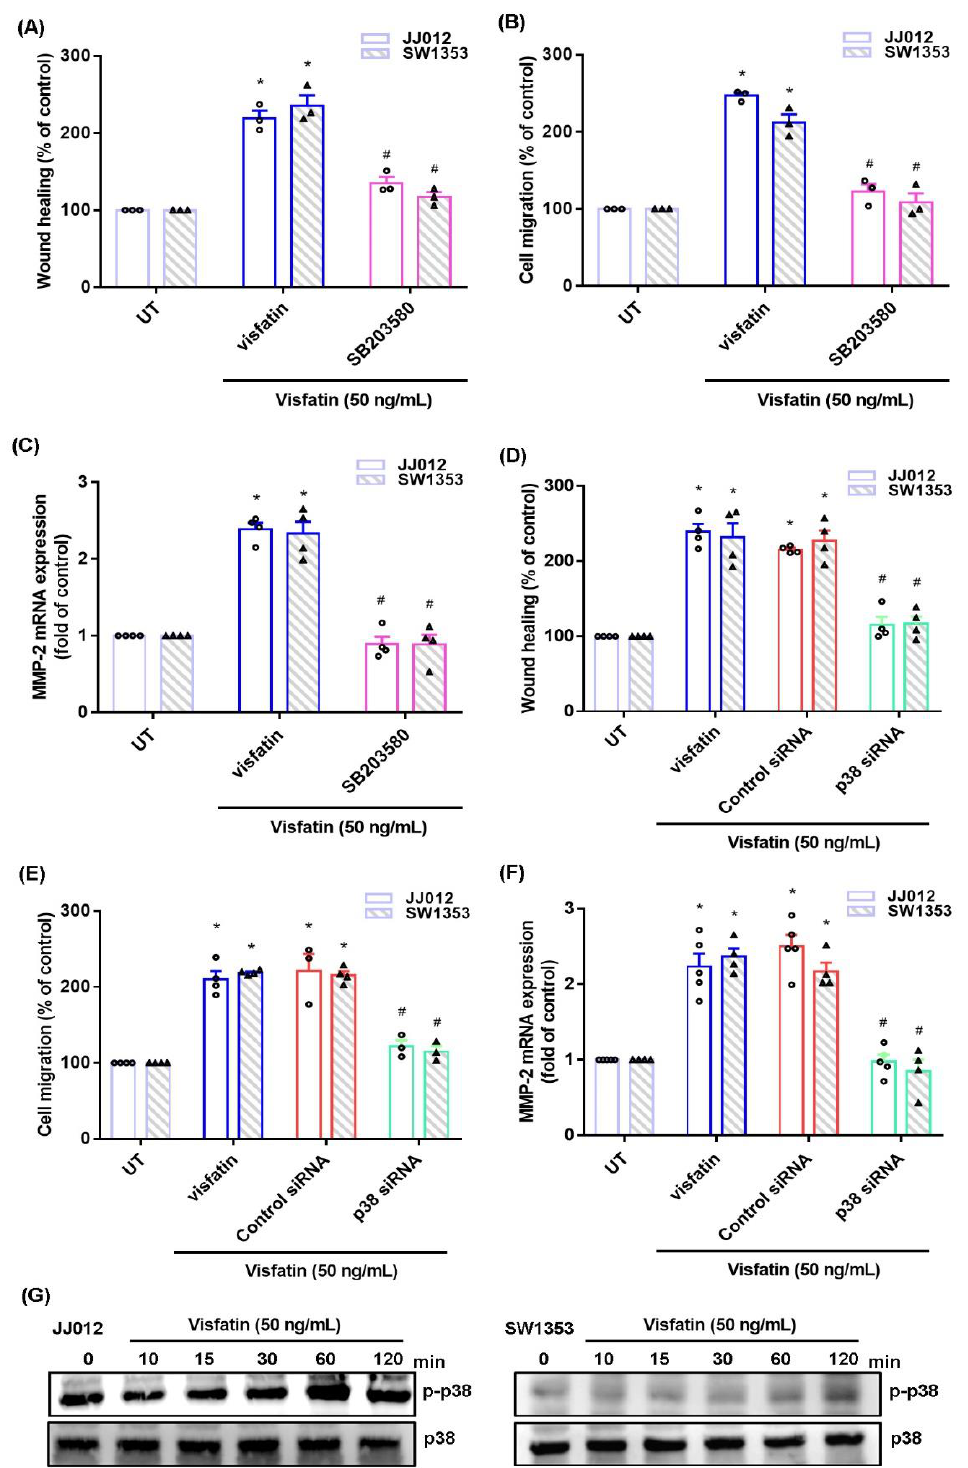
Figure 3. The p38 pathway mediates visfatin-induced MMP-2 expression and cell migration. ( A – F ) Cells were pretreated with a p38 inhibitor (SB253080) or transfected with a p38 siRNA, then stimulated with visfatin. Cell migration and levels of MMP-2 expression were examined by Transwell, wound healing, and qPCR. ( G ) Cells were incubated with visfatin for the indicated time intervals; p38 phosphorylation was examined by Western blot. Quantitative results are expressed as the mean ± SD. All experiments were repeated 3 to 5 times. * p < 0.05 compared with the UT group; # p < 0.05 compared with the visfatin-treated group. UT, untreated